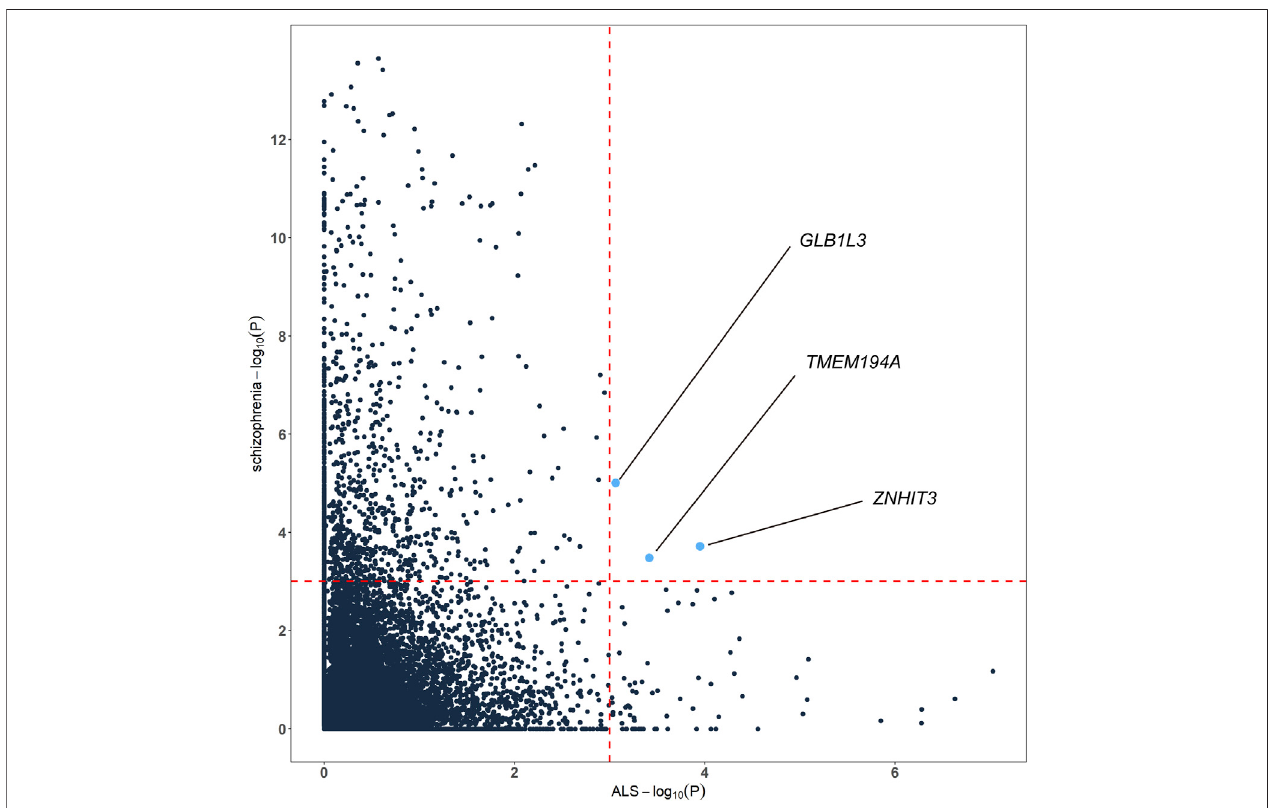
FIGURE 3 | Genes associated with both schizophrenia and ALS cross tissues . The red dashed lines denotes the false discovery rate (FDR) threshold of 0.001.